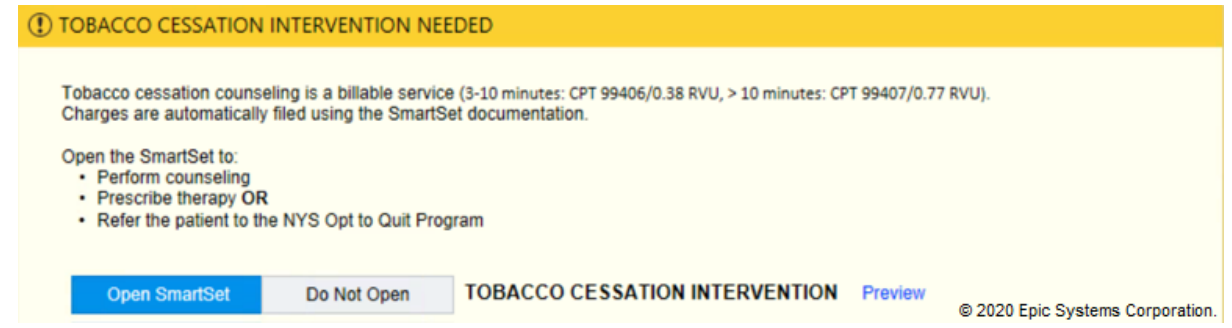
Figure 10. Tobacco financial messaging alert with no images tested in Round 3 of the randomized controlled trial. Copyright 2020, Epic Systems Corporation.